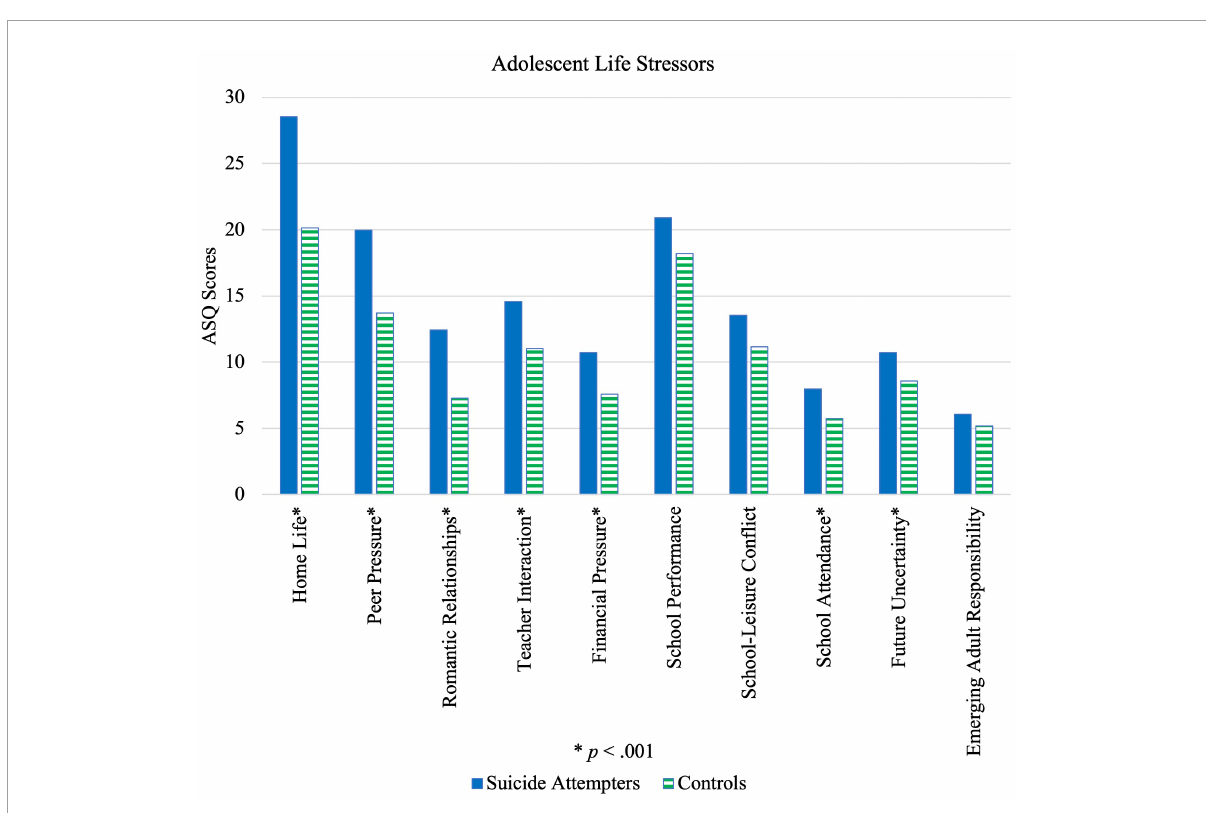
FIGURE1 Illustration of differences in life stressors reported by suicide attempters and control